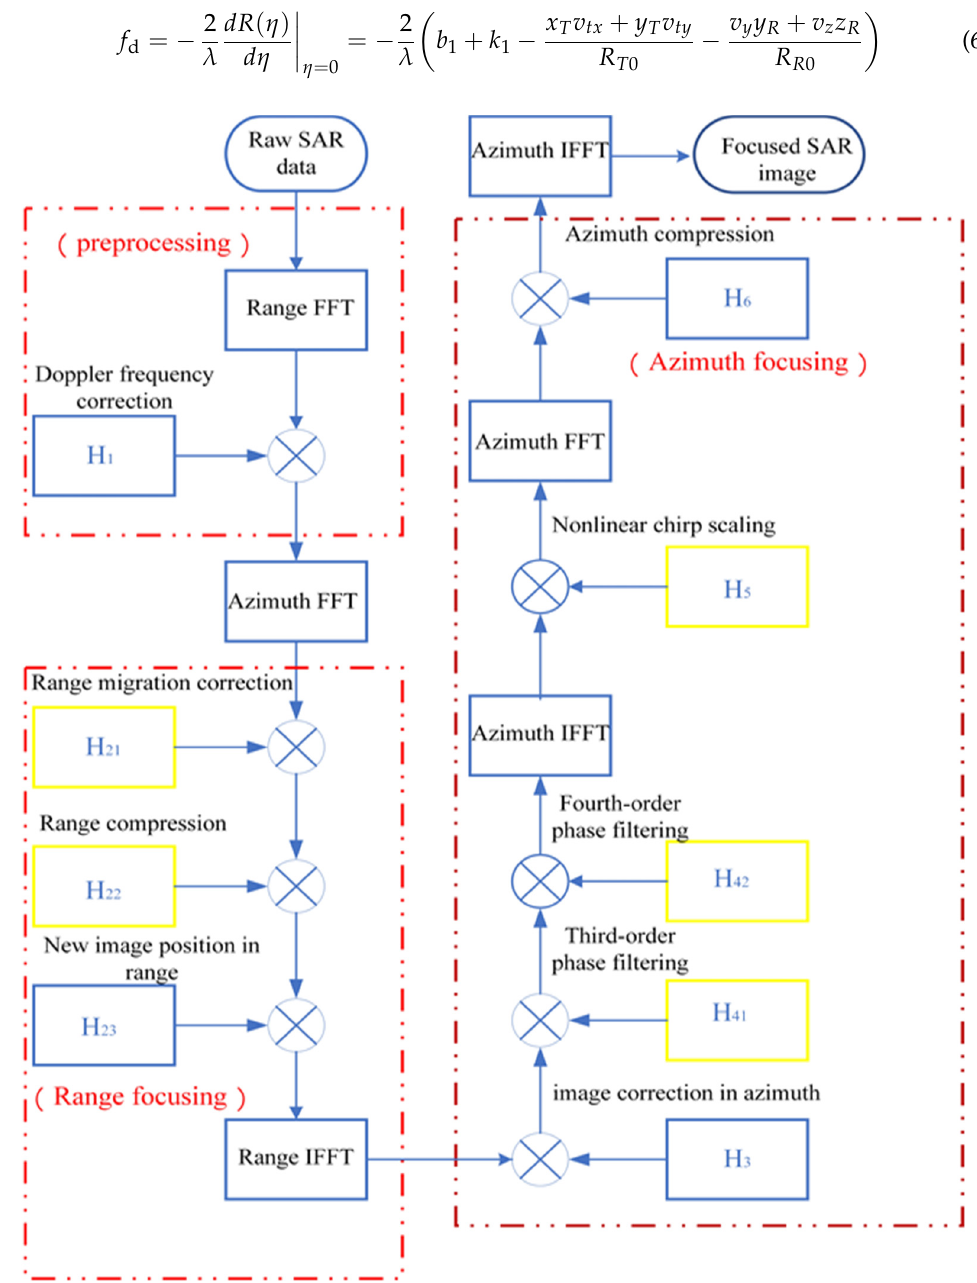
Figure 3. Flow chart of the proposed algorithm.